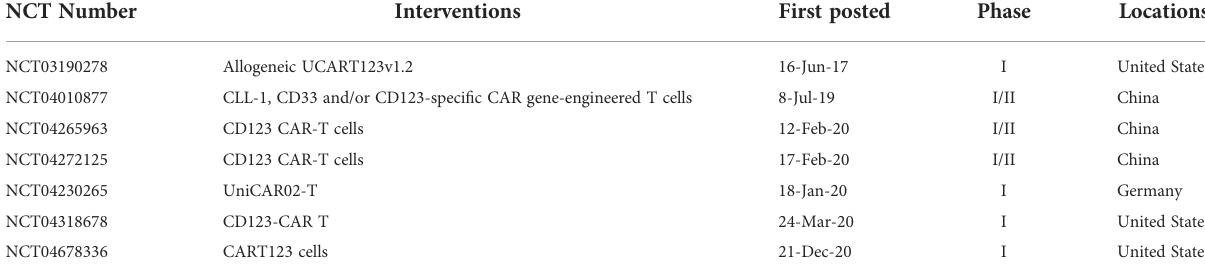
TABLE 4 Recruiting CD123 CAR clinical